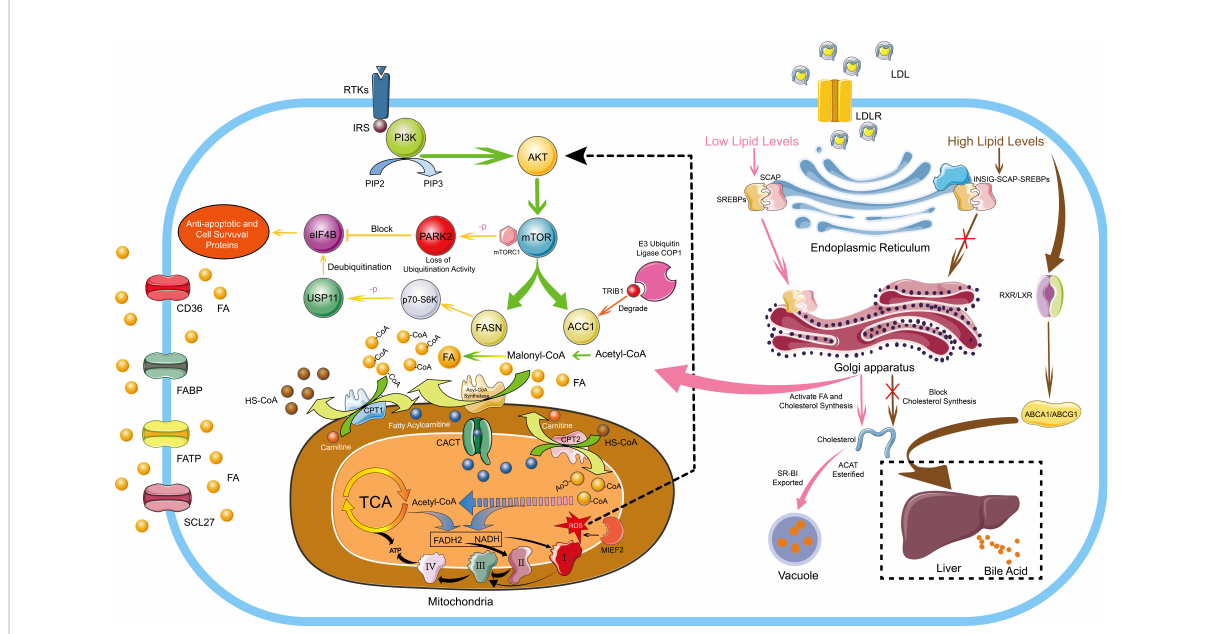
FIGURE 1 FA And Cholesterol Metabolism in Hematological Malignancies. The de novo synthesis of FA is regulated by the PI3K/Akt signaling pathway. De novo FA synthesis mainly depends on two key rate-limiting enzymes, ACC carboxylates acetyl-CoA to malonyl-CoA, and FASN converts acetyl-CoA and malonyl-CoA Conversion of acyl-CoA to long-chain FA. ACC and FASN are regulated by mTOR, which is a downstream target of the PI3K/Akt signaling pathway. Overexpressed FASN can prompt p70-S6 kinase to phosphorylate USP11 and the phosphorylated USP11 mediates eIF4B deubiquitination to increase its stability. eIF4B mediates the expression of anti-apoptotic and cell survival proteins, ultimately driving the development of lymphoma. In addition, PARK2 can also be phosphorylated by mTORC1 to lose its ubiquitination activity, thereby blocking the ubiquitination and degradation of eIF4B protein. The E3 ubiquitin ligase COP1 binds to ACC1 through Trib1 and causes ACC1 ubiquitination and degradation to inhibit FA synthesis. Cells uptake exogenous FAs mainly through CD36, FATP, FABP and SCL27. Endogenous FAs and exogenous FAs enter the mitochondria through the transmembrane mechanism, and generate a large amount of ATP through FA b -oxidation, the TCA cycle and the electron transport chains. Moreover, MIEF2, a key regulator of mitochondrial fi ssion, can stimulate the production of mitochondrial ROS and activate the AKT/mTOR signaling pathway to further enhance FA synthesis. Cholesterol homeostasis is mainly regulated by SREBPs and LXRs. In conditions of low cholesterol levels, SCAP-SREBP2 can be smoothly transferred from the ER to the Golgi apparatus to activate the de novo synthesis pathway of cholesterol. In conditions of high cholesterol levels, INSIG, SCAP and SREBP2 form a stable trimolecular complex to block the export and activation of SREBP2, and fi nally inhibiting the de novo cholesterol synthetic route. Moreover, by activating LXR-RXR to express ABCA1 and ABCG1, excessive cholesterol is transported to the liver and excreted in the form of bile acids. Furthermore, excessive cholesterol is rapidly esteri fi ed and exported under the action of ACAT and SR-BI to form vacuoles containing cholesterol ester derivatives. I, II, III and IV represent complex I, complex II, complex III and complex IV in the electron transport chains,